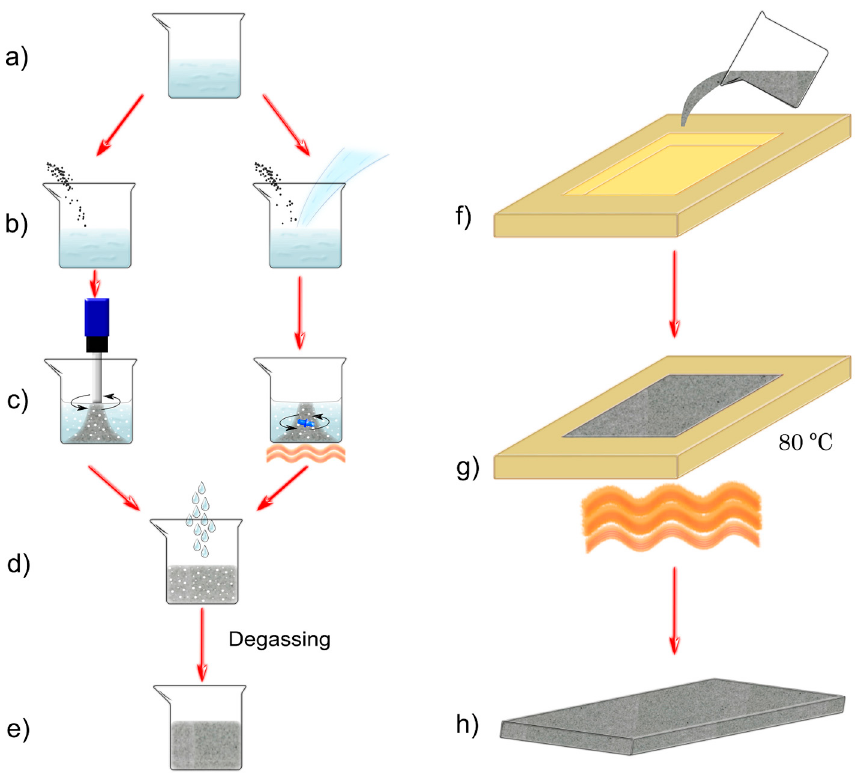
Figure 2. Preparation method for the PDMS/CNP membranes showing two mixing processes to obtain different CNP cluster sizes . ( a ) Weighting of the silicone oil inside of a glass beaker , ( b ) addition of the CNP to the PDMS, ( c ) mixing of the CNP with PDMS (evaporation by heat (orange lines) when CHCl 3 is used), ( d ) addition of curing reagent, ( e ) degassing of the blends, ( f ) PDMS/CNP mixture poured into a glass mold, ( g ) curing process by heat (orange lines) at 80 °C for solidification, and ( h ) unmolding PDMS/CNP samples.